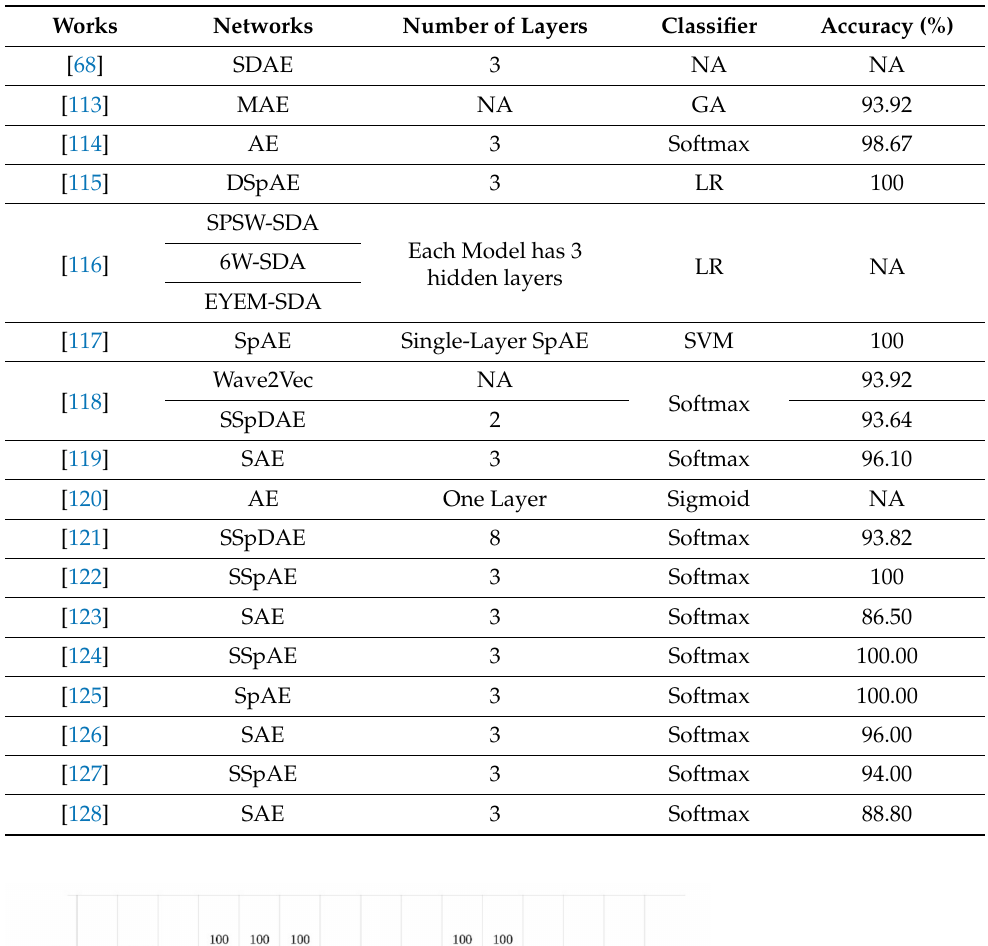
Table 5. Summary of related works done using AEs.